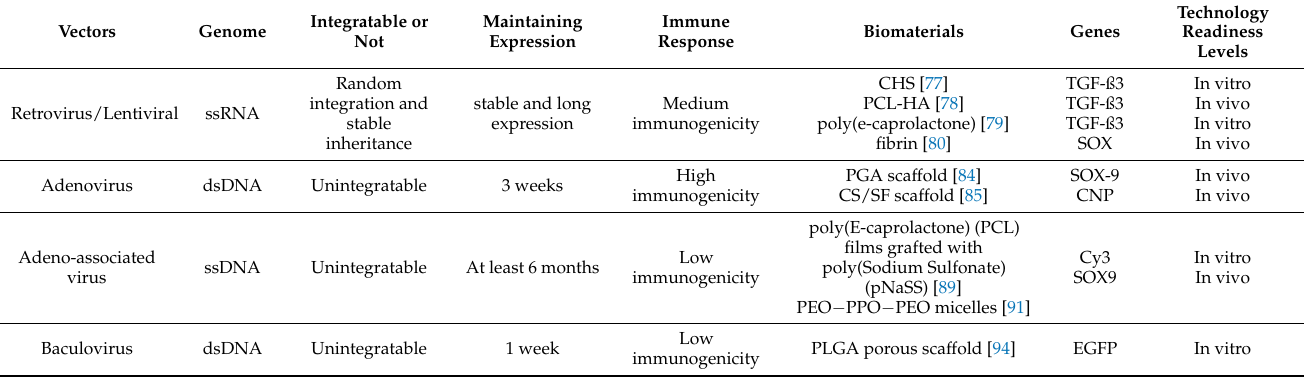
Table 3. A comparison of different virus vectors used in biomaterial-mediated gene